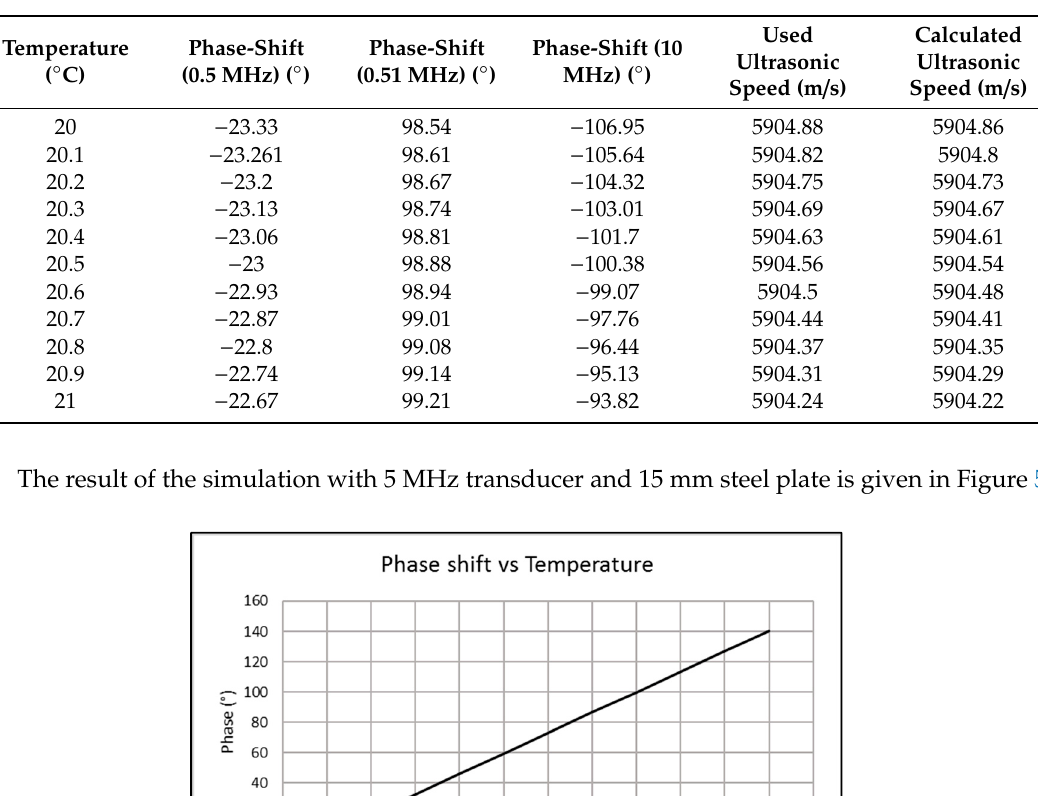
Table 3. Simulation results using multiple frequency continuous wave method (MFcw) technique.